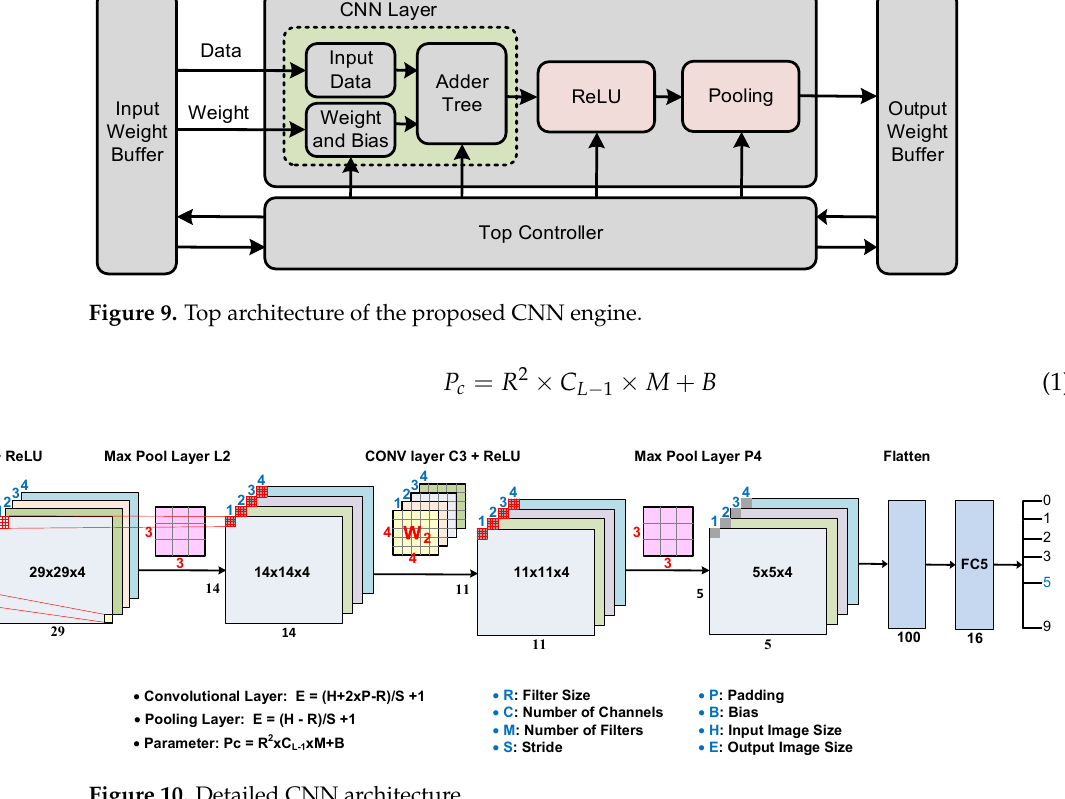
Figure 9. Top architecture of the proposed CNN engine.